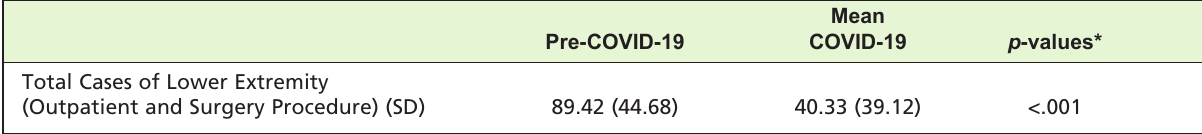
Table I: Total lower extremity patient pre-COVID-19 and COVID-19 period